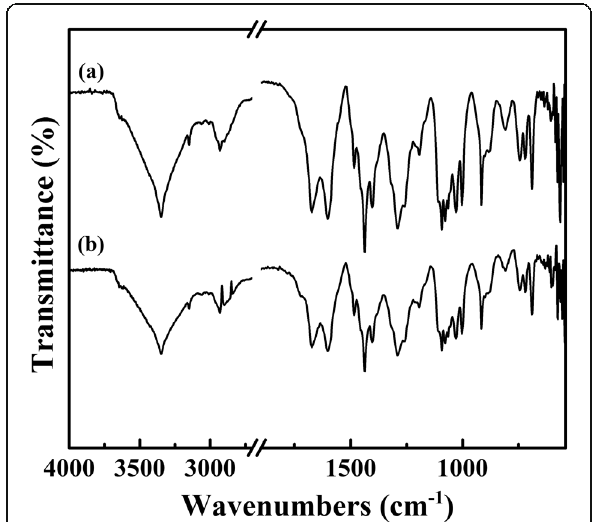
Fig. 8 FT-IR spectra of (a) fresh TPDB-BP-TEA and (b) reused TPDB-BP-TEA. FT-IR spectrum of the recovered catalyst suggests the well-preserved textural properties relative to the fresh one, accounting for its well recyclability